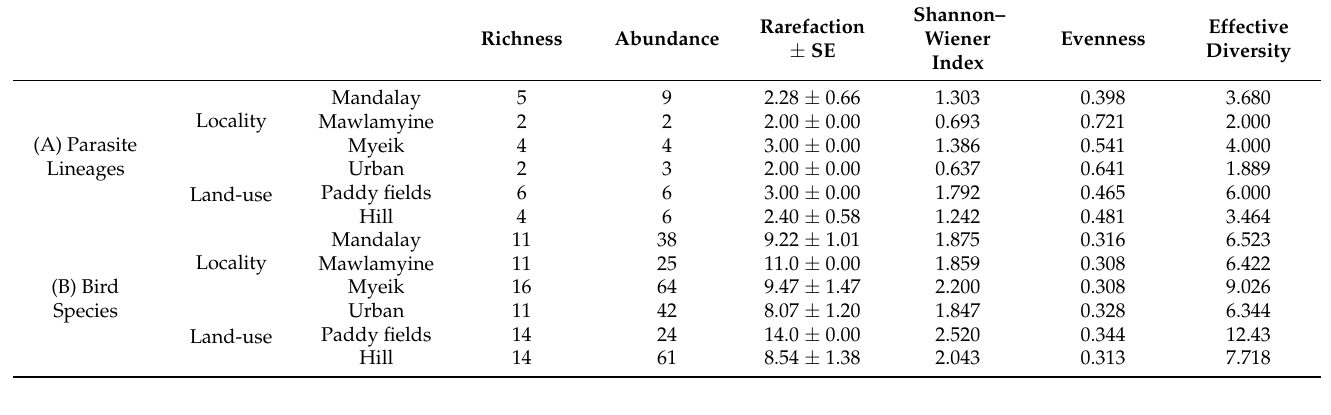
Table 2. Estimates of (A) parasite lineage diversity and (B) avian diversity based on the number of birds handled in three localities and three land-use types. Richness